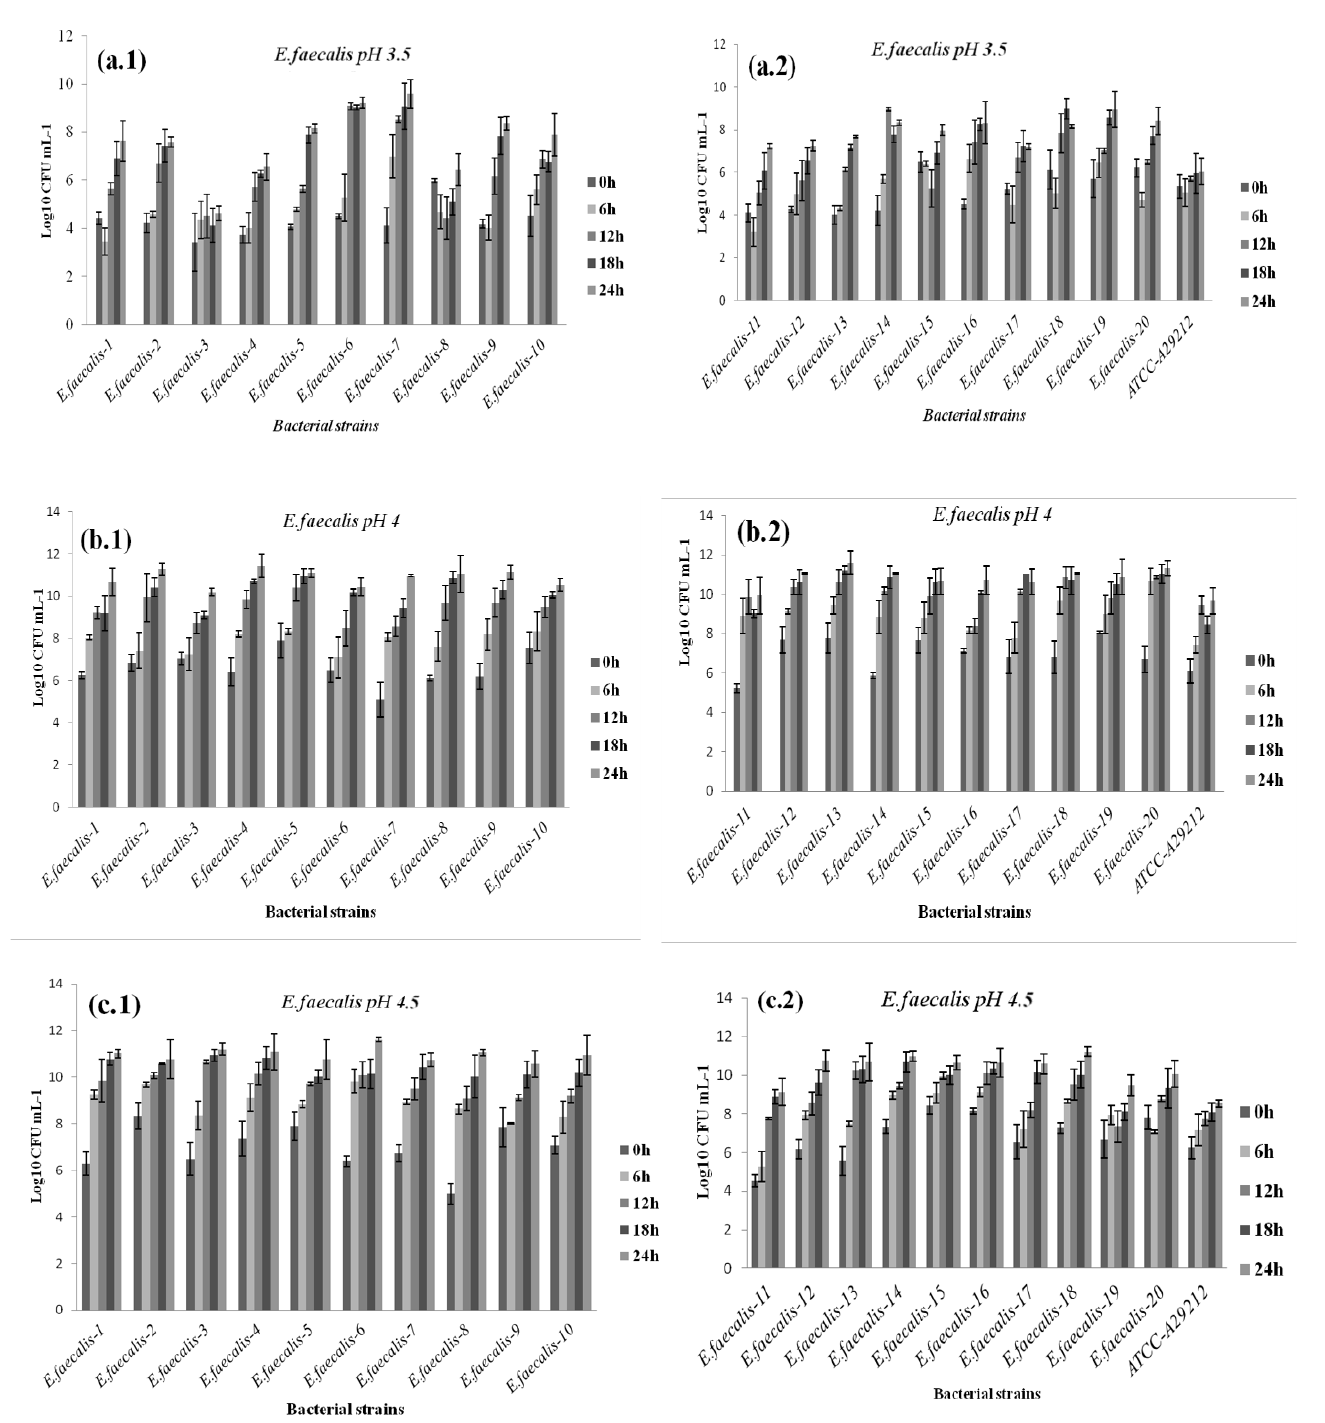
Figure 4. Growth of vaginal Enterococcus faecalis strains at pH 3.5 ( a1 , a2 ); pH 4 ( b1 , b2 ); and pH 4.5 ( c1 , c2 ).